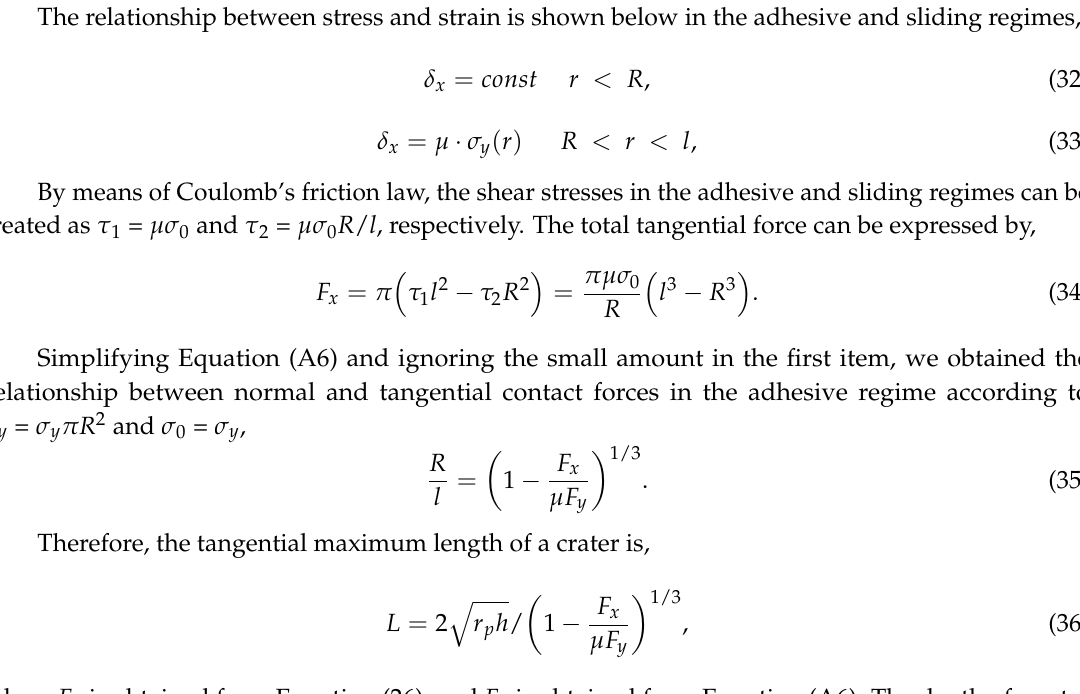
Figure 4. Sliding contact diagram: ( a ) adhesive areas and sliding areas; ( b ) the distribution for shear stress. The relationship between stress and strain is shown below in the adhesive and sliding regimes,